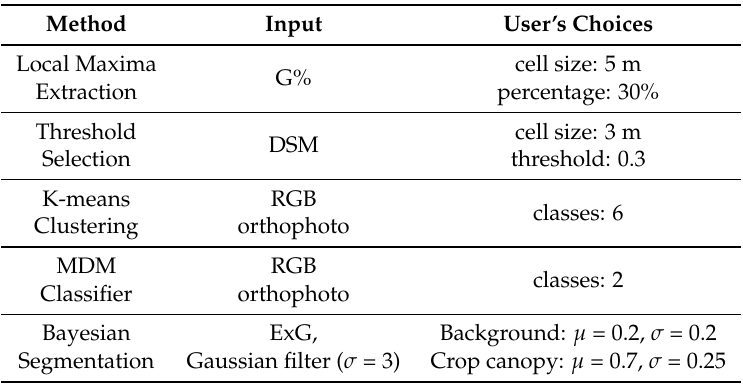
Table 5. Vineyard site: parameters for the best results of each detection method. MDM, Minimum Distance to the Mean.